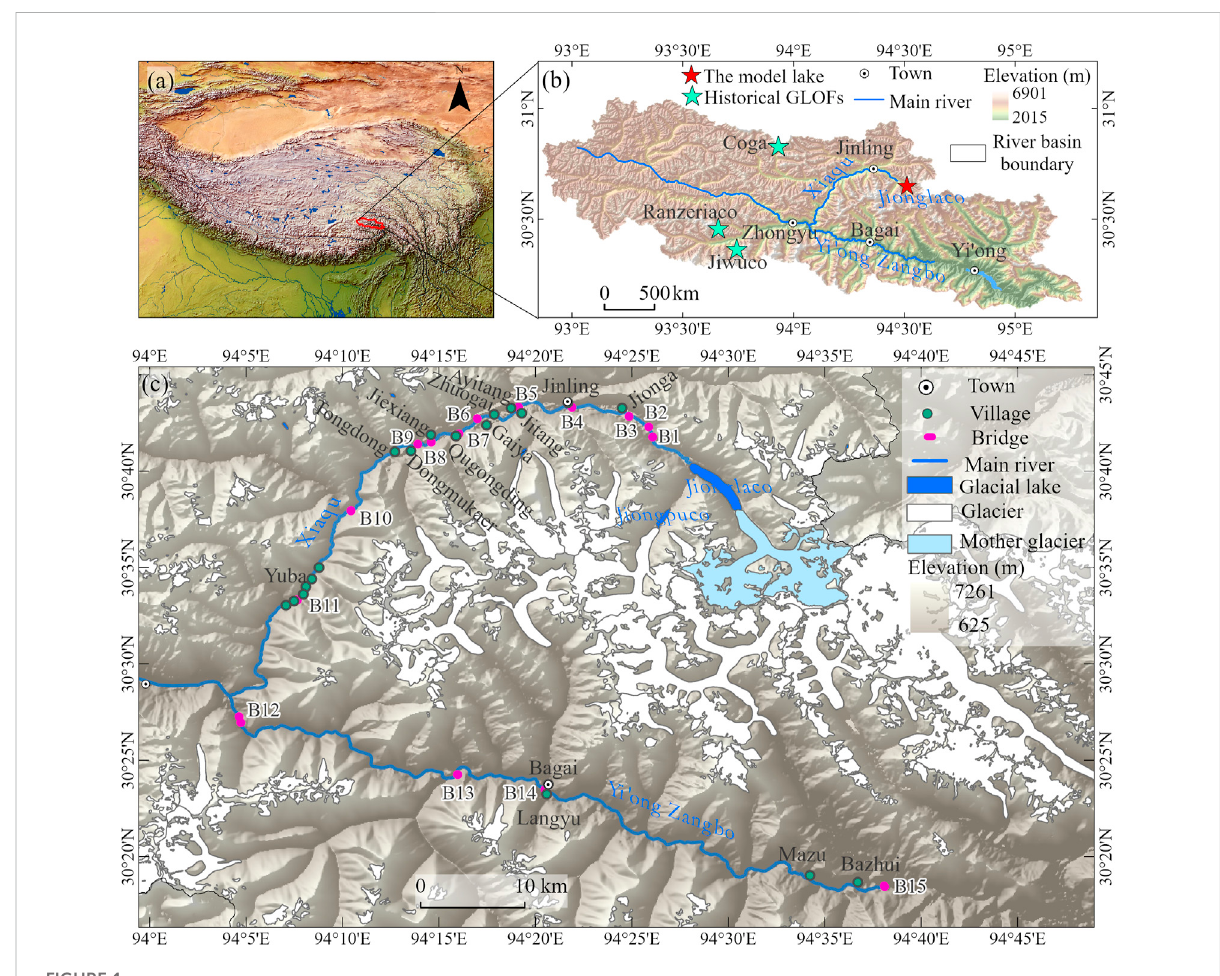
FIGURE 1 Study area showing the (A) location of the Yi ’ ong Zangbo River basin in the Qinghai – Tibet Plateau, (B) historical GLOFs and Jionglaco, and (C) towns, villages, and bridges along the downstream river of